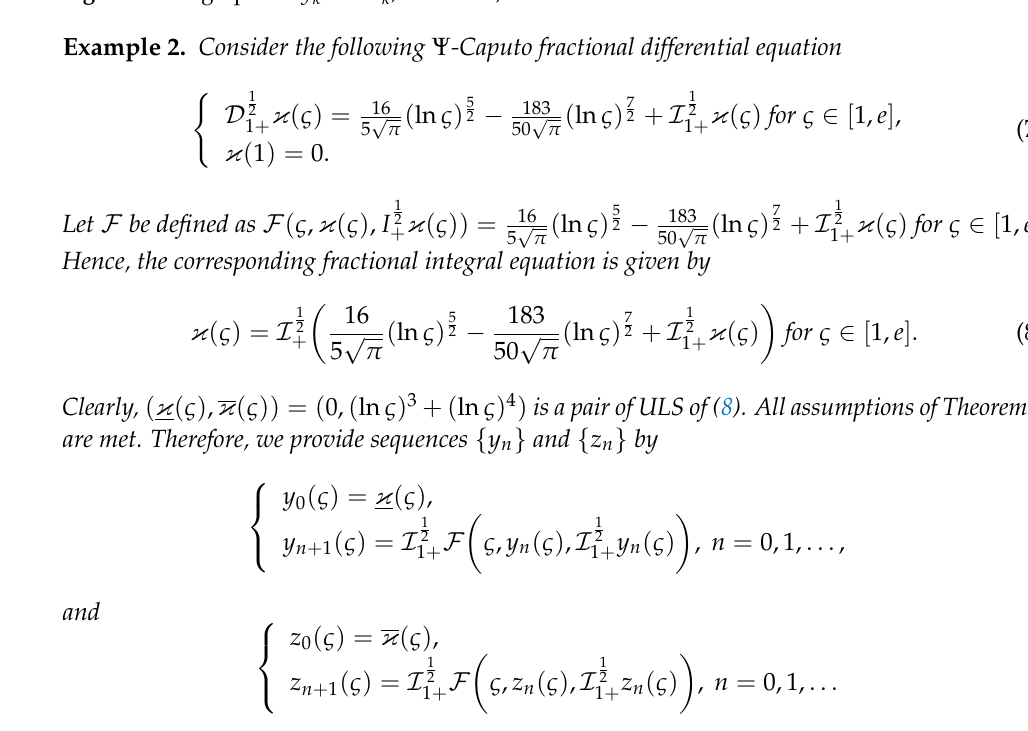
Figure 1. The graphs of y k and z k , for k = 0,1.